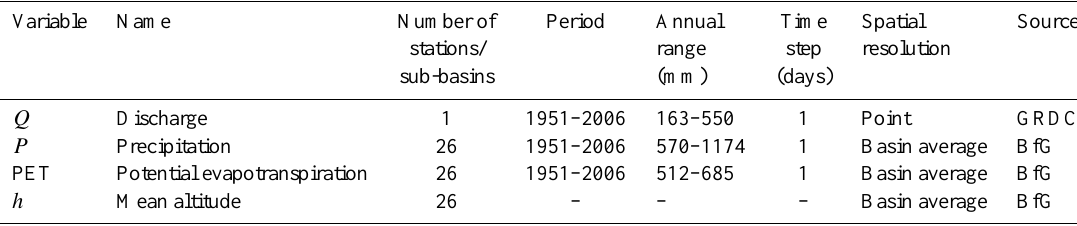
Table 1. Overview of observed data used.